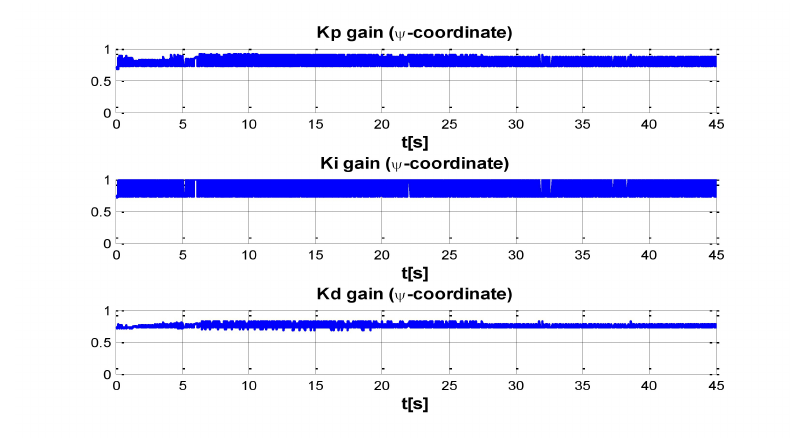
Figure 11. PID gain time behavior in z-coordinate.